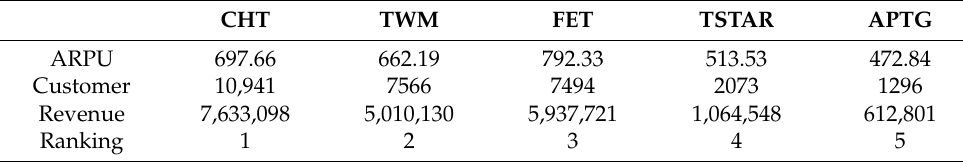
Table 6. Revenue of the mobile operators in